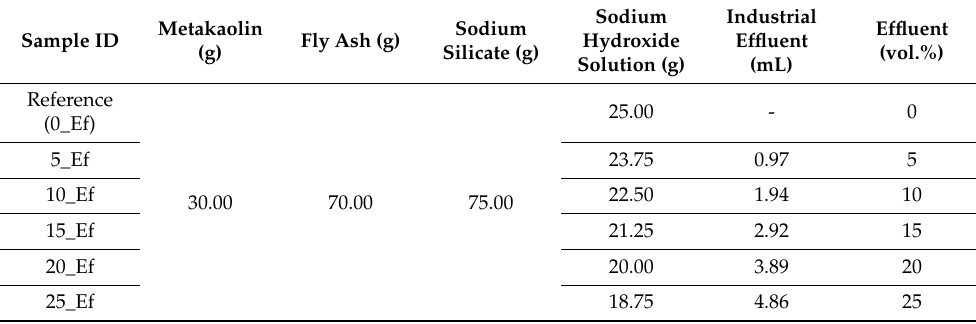
Table 1. Mixture composition of the studied formulations. The amount of effluent used to replace sodium hydroxide is provided in mL, and the corresponding vol.% is